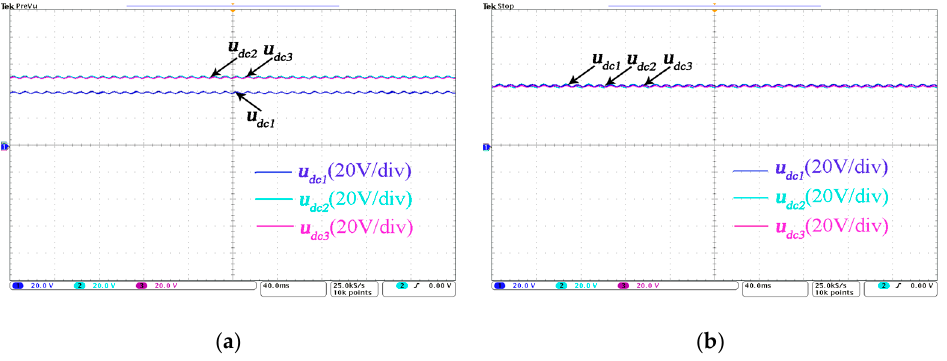
Figure 10. Maximum adjustable power factor comparison between the theoretical calculation values and experimental values under different step-up ratio k .